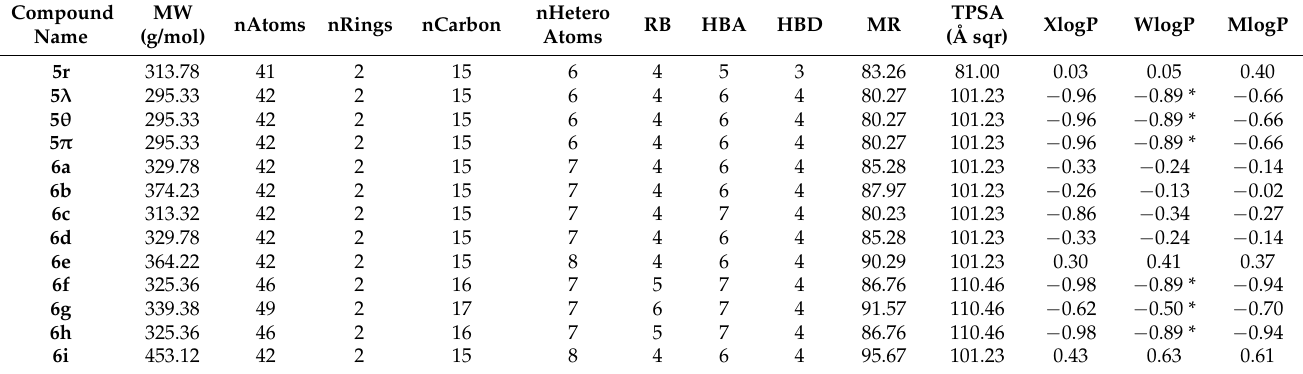
Table 3. Physiochemical properties of the compounds predicted by SwissADME and admetSAR.